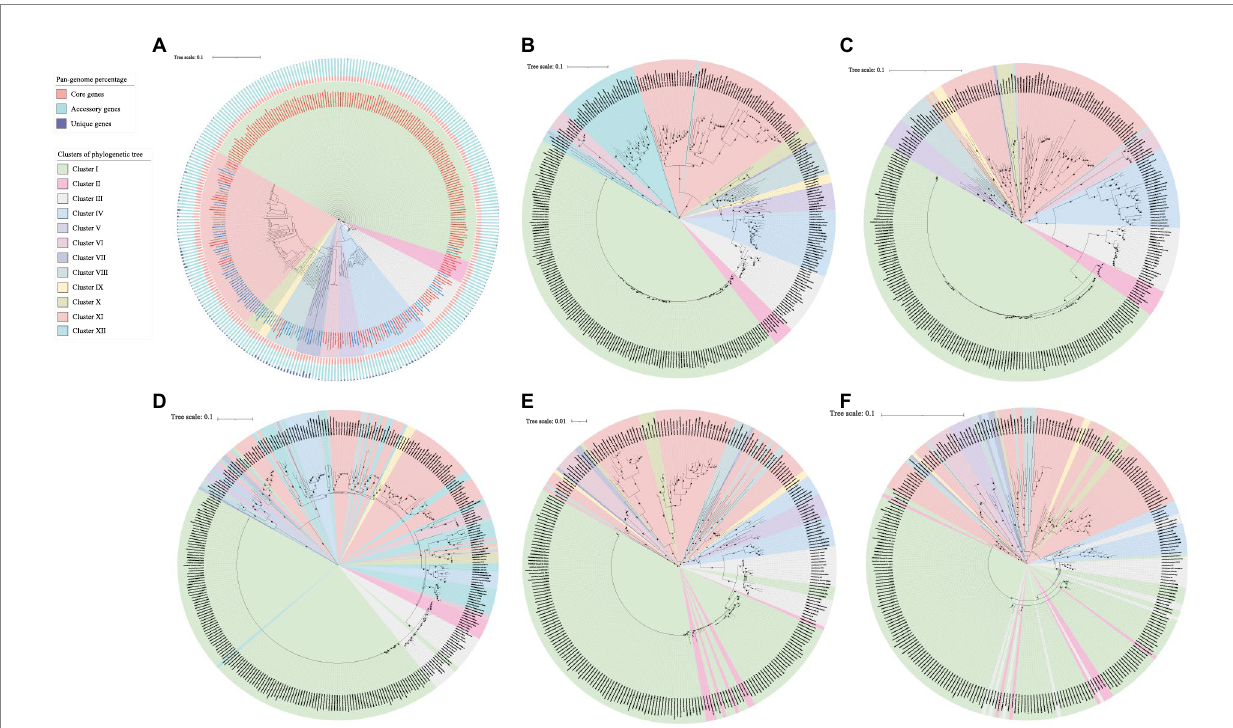
FIGURE 1 Phylogenetic tree of Acinetobacter constructed based on the amino acid sequences of core genes (A) , AlkM (B) , AlmA (C) , CatA (D) , BenA (E) , and BenB (F) . Clinical strains are indicated in red font; animal strains are indicated in gray font, and environmental strains are indicated in blue font. The three colors in the bar graph represent the percentage of core, accessory, and unique genes in the pan-genome,